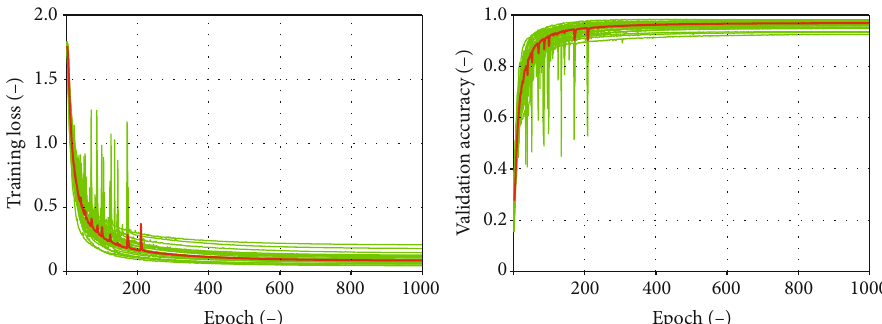
Figure 11: Training history of DNN-opt; green indicates the 30 independent runs, and red the summarized outcome (averaged value excluding the best/worst 5